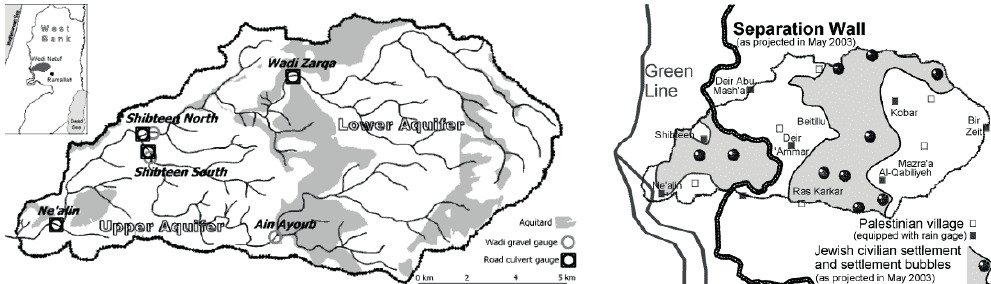
Fig. 1 Wadi Natuf overview maps. Left: drainage, aquifers and runoff gauging sites; right: villages (with tipping buckets), settlement clusters and envisaged annexation zones. Note: On 30 May 2003, Israeli newspaper Ma’ariv presented the route of the separation wall and the settlement clusters earmarked for de facto takeover. Shibteen and Ne’alin would have fallen into no-man’s land behind the wall. After international protests and the ICJ ruling against the Israeli wall in the midst of the West Bank, its route was temporarily repositioned. Not all of the settlement clusters have been established, yet the map gives a good impression of their continuous expansion and the ultimate goal of land control. Table 1 Land forms – runoff sensitive land characteristics along regions in Wadi Natuf. factors Upper Wadi Natuf Central Wadi Natuf Lower Wadi Natuf East Middle West Geography Eastern highlands Central hills and plains Western foothills Topography, relief Relief steep slopes, terraces gentle hills, some plains & terraces gentle slopes, big plains, no terraces Hydrostratigraphy Lower Aquifer Middle Aquitard Upper Aquifer Soil class, thickness terra rossa 30–90 cm terra rossa, pale rendzina 45–120 barren rock, terra rossa 0 – 70 cm cm Vegetation cover olive, arable/natural olive, arable/ natural vegetation, grassland/barren (olives, arable/ vegetation, grassland grassland, forest natural vegetation) Land cover, indexed 1, 2, 3 2, 3 (1, 4) ((5)) 1 (2, 3) Active agriculture none rainfed, complex cultivation none Rainfall (relative) high middle to high low to middle Runoff